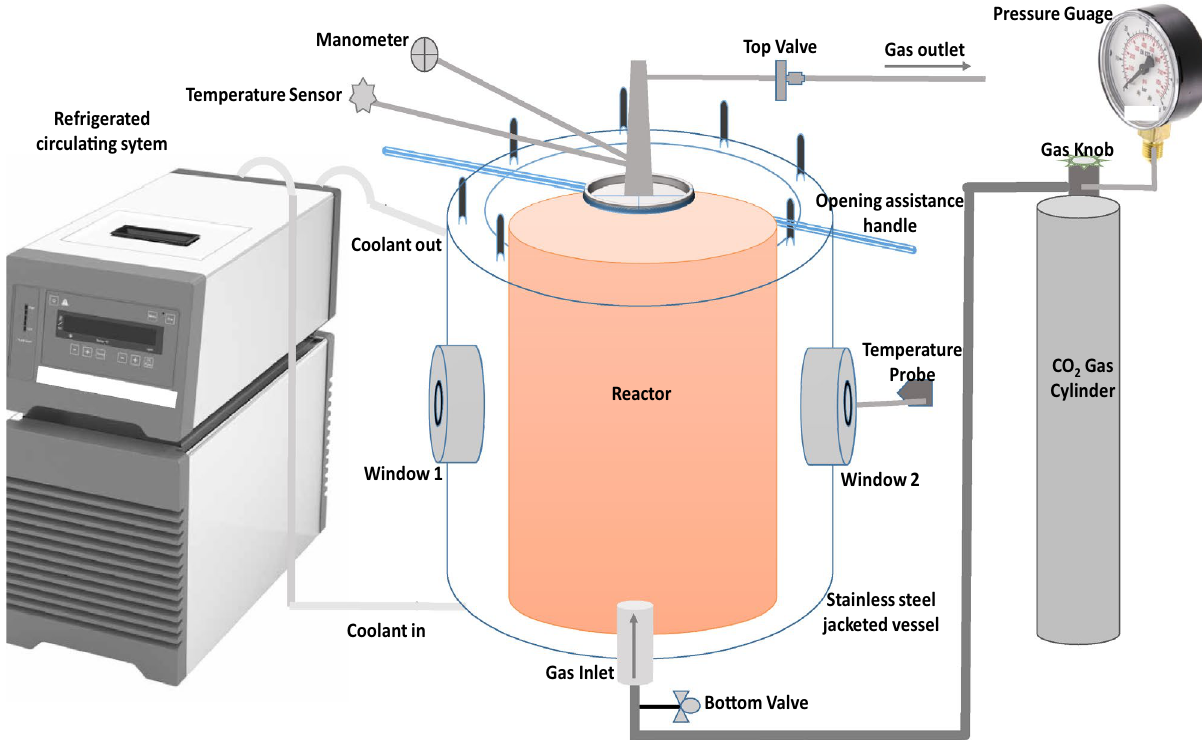
Figure 6. Schematic representation of gas hydrate reactor